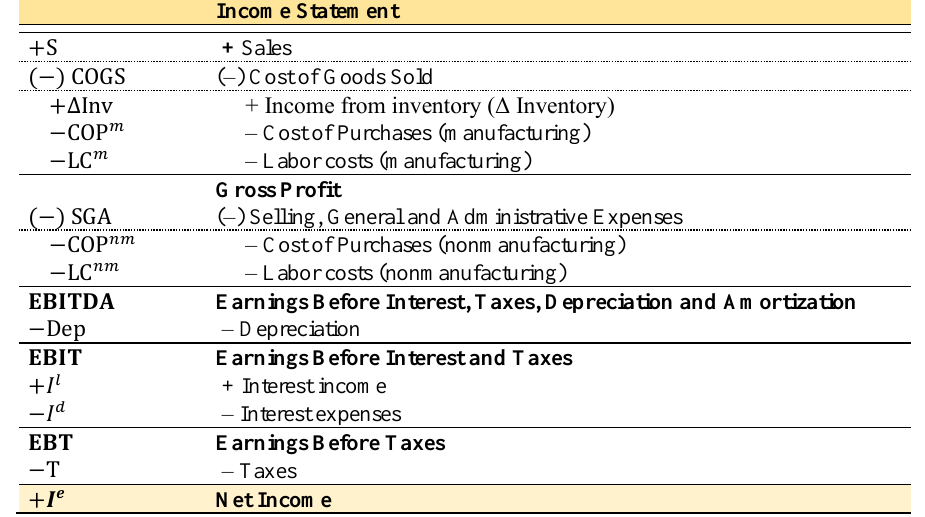
Figure 5. Income Statement with twofold classification of costs, by nature and by function (see also Figure